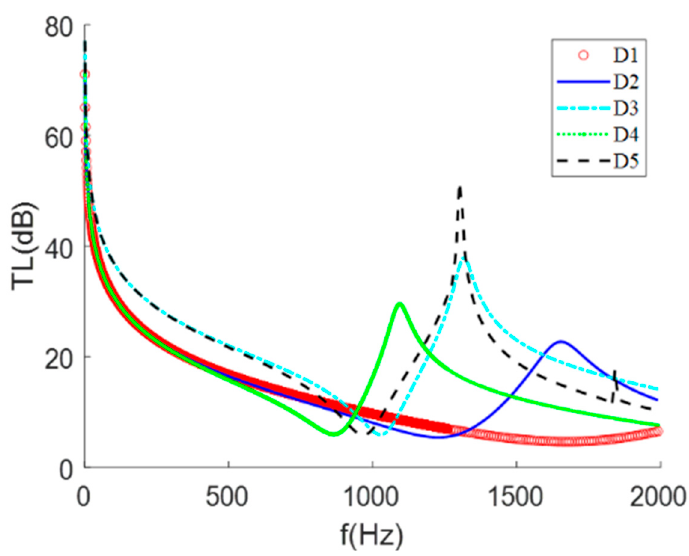
Figure 9. Acoustic transmission loss of each defect state structure.